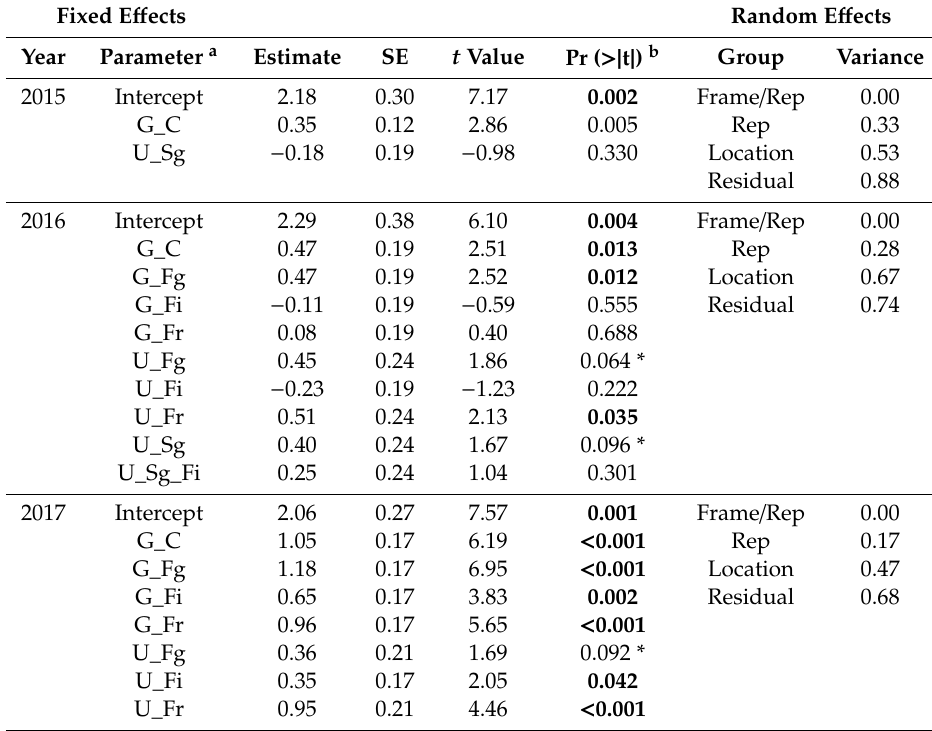
Table 6. The response of forb cover to grazing and / or herbicide treatments, analyzed using a linear mixed e ff ects model. All treatments (parameters) are with respect to the ungrazed control treatment (U_C), which is the intercept in the model. In 2015 only the grazed (G) and ungrazed control, and the spring applied herbicide treatment results are shown, because fall herbicide application had not yet occurred. Results are based on log transformed forb